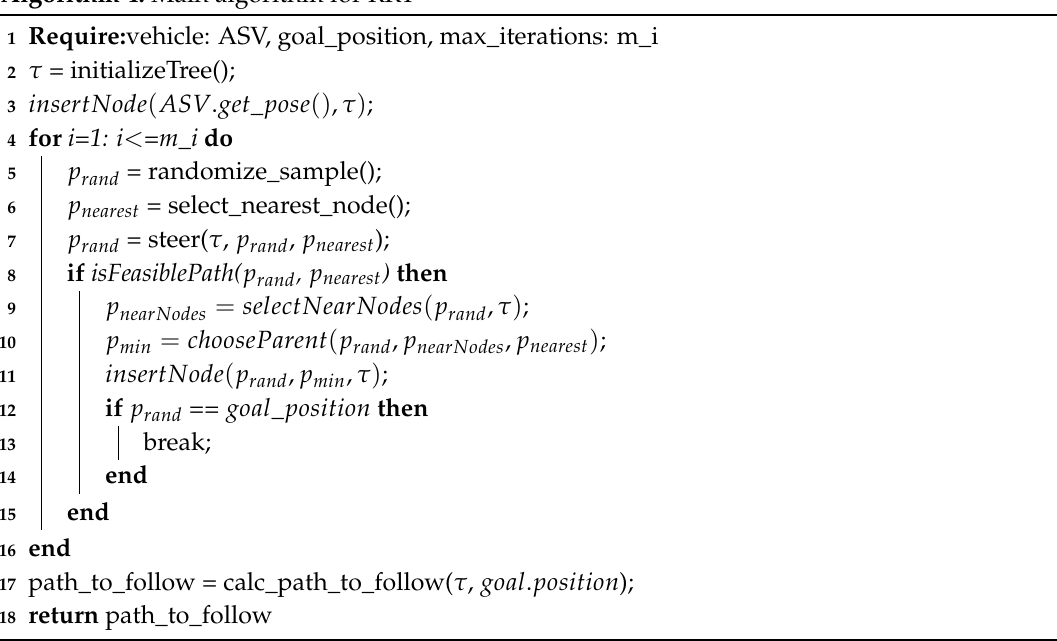
Figure 6. RRT* sequence diagram. 1: The path should go from end to start. Algorithm 4: Main algorithm for